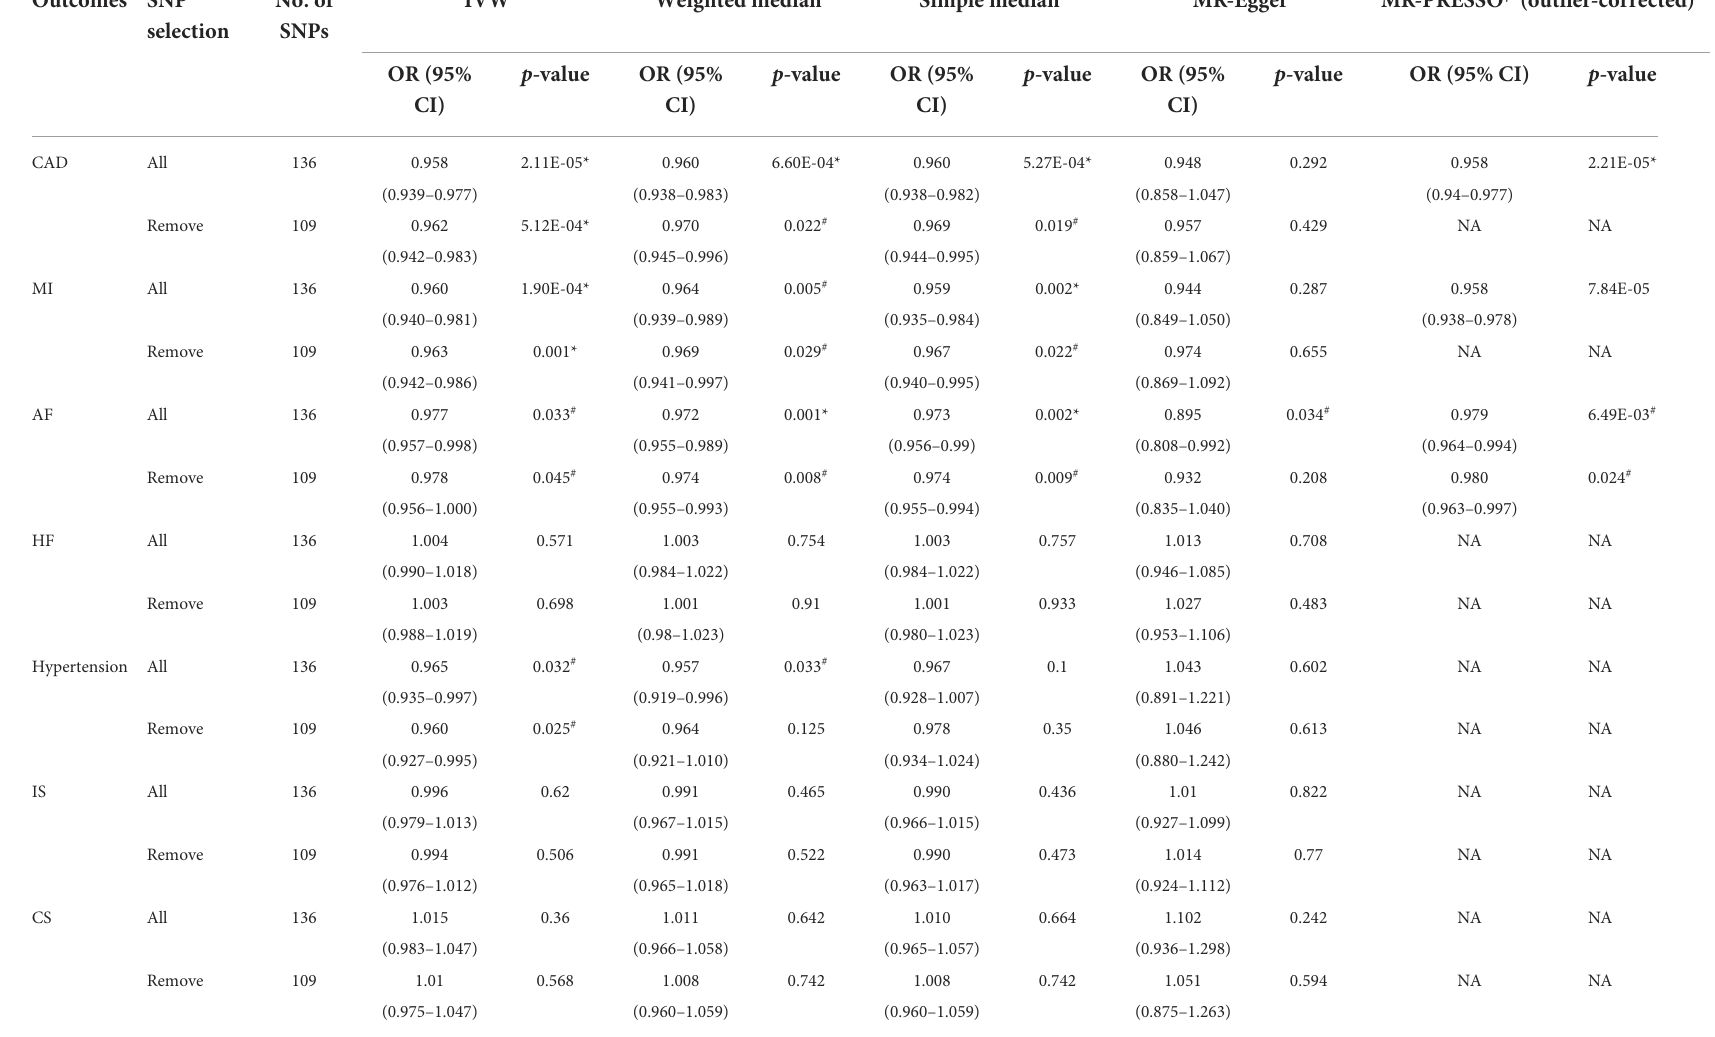
TABLE 2 Mendelian randomization estimates between left handgrip strength and cardiovascular